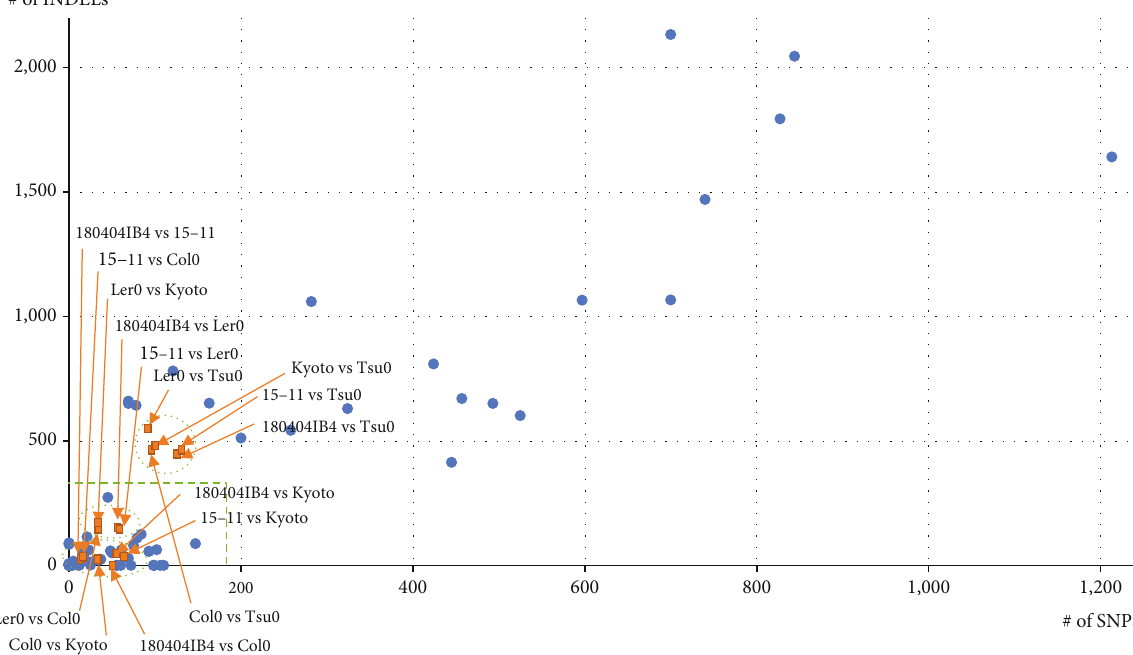
Figure 3: Plot of the numbers of SNPs and INDELs identi fi ed as intraspeci fi c variations from chloroplast genomes. X -axis indicates the number of SNPs and Y -axis means the number of INDELs. Yellow-colored boxes indicate intraspeci fi c comparisons of A. thaliana chloroplast genomes. Green dotted circles show a group of intraspeci fi c comparisons. Thick green dotted line displays border between low level of intraspeci fi c sequence variations and high level of intraspeci fi c